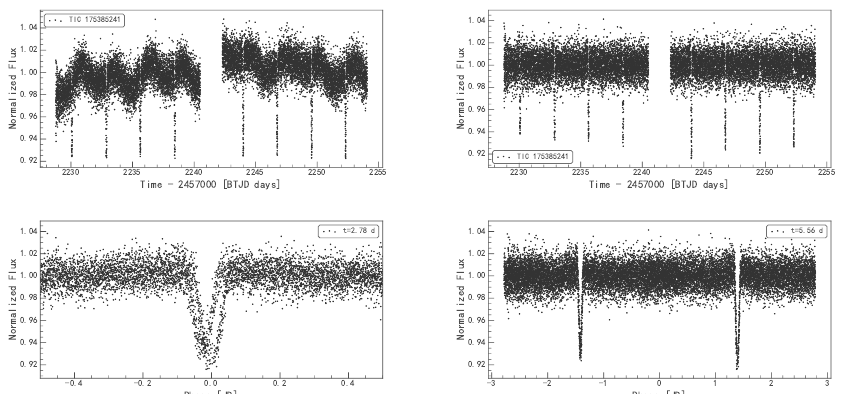
Figure 7. TESS light curve of Gaia DR2 5536809162106730112 (Sector 34). From top to bottom, light curve before detrending, after detrending, phase-folded to the period of 2.78 d, and to the period of 5.56